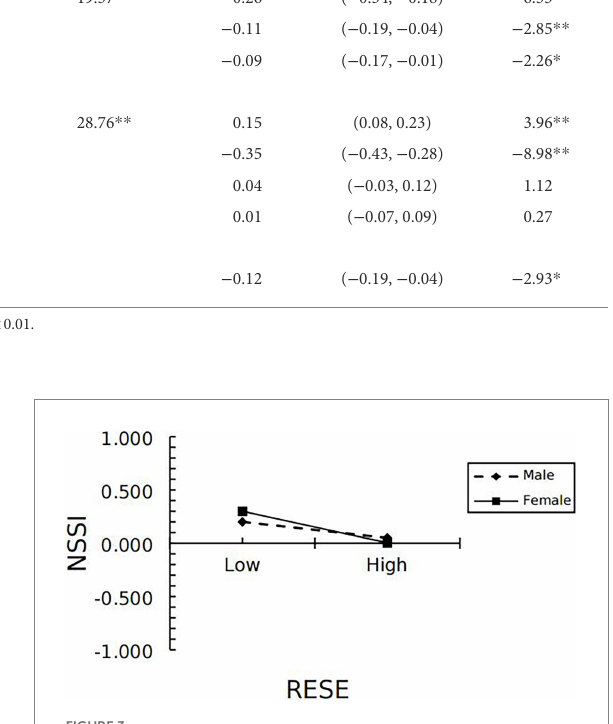
FIGURE 3 Model of the test for simple slopes showing the moderating influence of gender of the association between RESE and